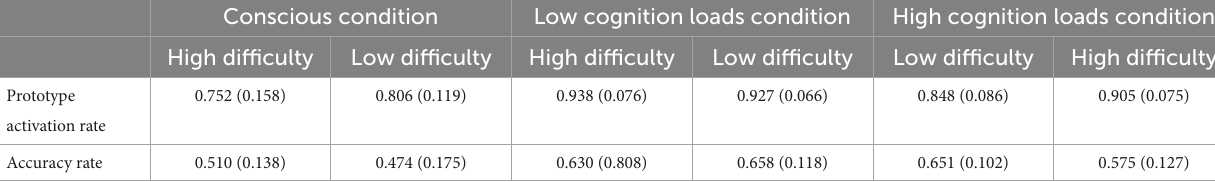
TABLE 2 Descriptive statistics of prototype activation rate and accuracy rate in different conditions (M ±